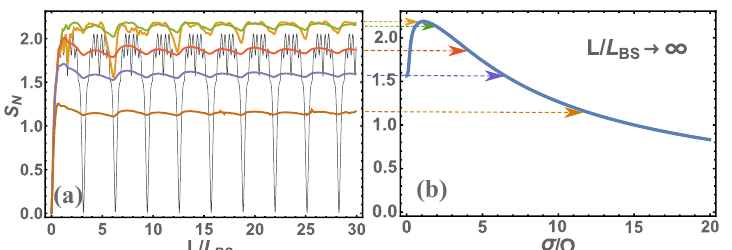
Figure 4. The calculation for the initial state | 4,4 (cid:105) is presented: ( a ) quantum entanglement S N at different parameters σ / Ω = { 0,1/2,3/2,3,5,10 } (respectively, the color of the graphs in the figure: { black, yellow, green, red, blue, brown } ) depending on the dimensionless BS length L / L but at larger BS size, i.e., at L / L BS → ∞